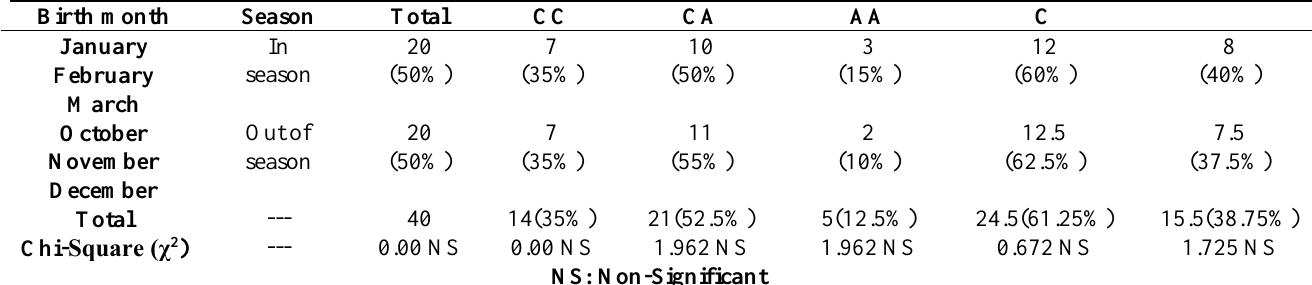
Table 4. Distribution of allele frequency of MTNR1A gene in local goats according to birth season (out or in